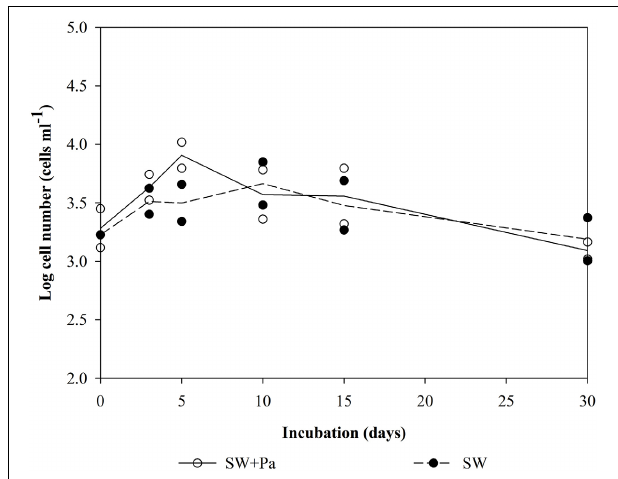
FIGURE 2 | Number of protist cells in the SW and SW + Pa microcosms over the course of the study. Each value is an average of duplicate measurements. < DL, below detectable level. Protists were not detected in other micrososms.